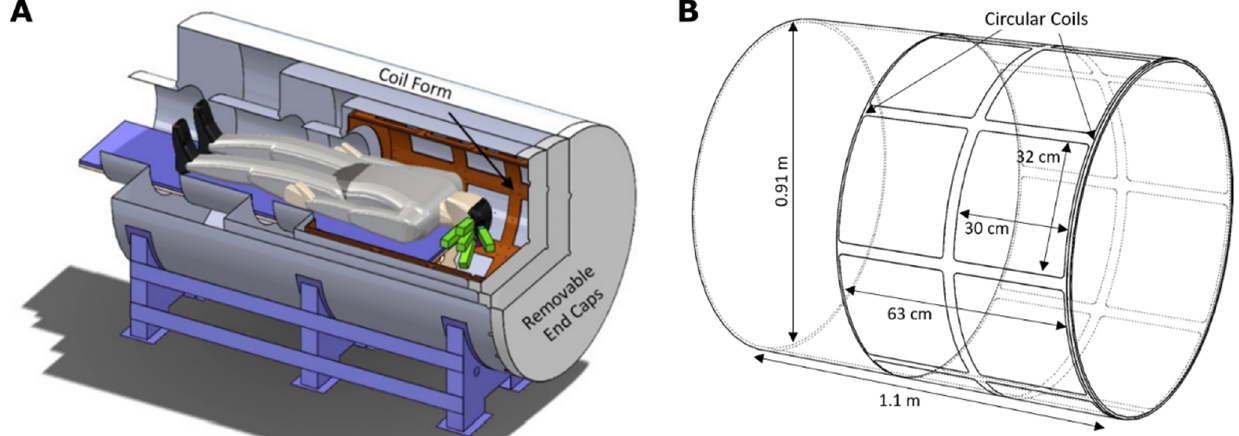
Figure 1. An overview of the OPM–MEG system: ( A ) 3D rendering illustrating the positions of the OPMs (green) inside the shield. Form for the electromagnetic coils is highlighted [18]. ( B ) Schematic illustration of the 16 rectangular and 2 circular coils embedded in the coil form within the shield.